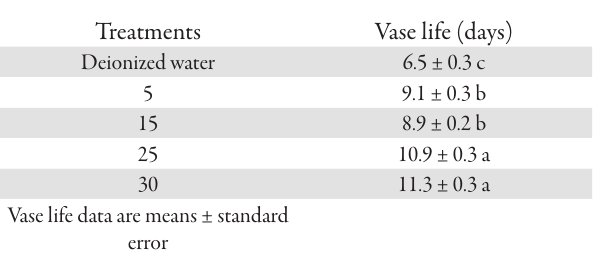
Tab. 1. Vase life of L. orientalis ‘Bouquet’ various SNPs treatments